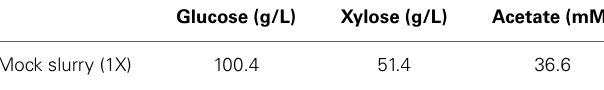
Table 1 | Composition of mock saccharified hydrolysate